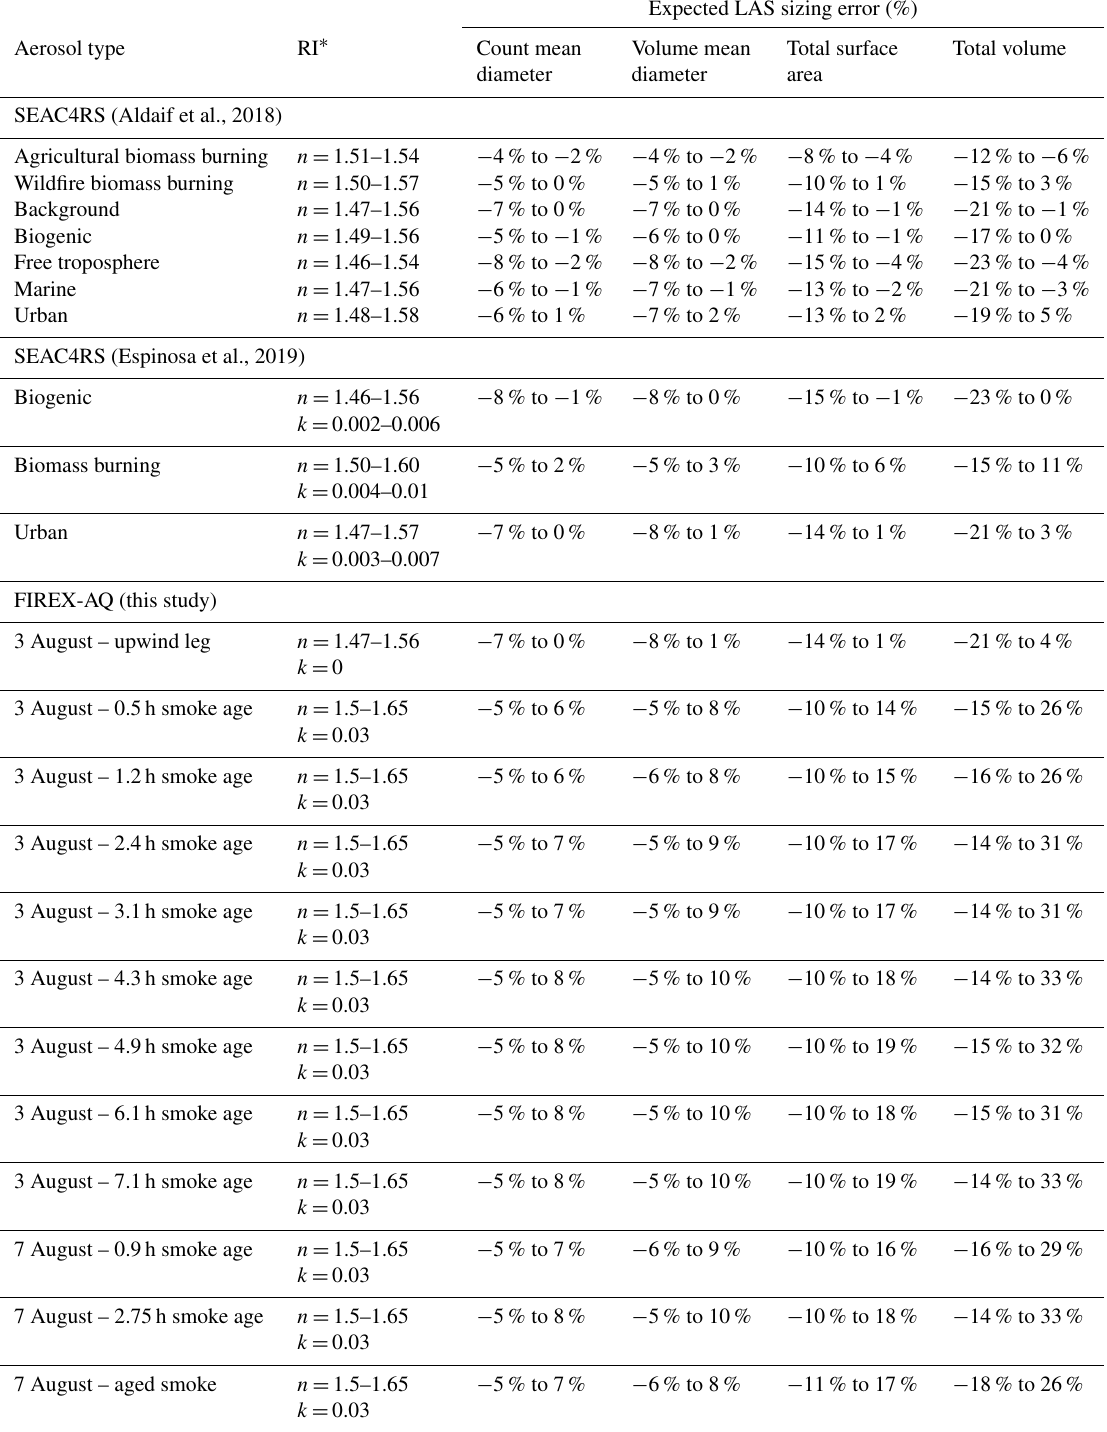
∗ RI range for SEAC4RS computed from literature values as the reported median ± 1 . 5 times the interquartile range for Aldaif et al. (2018) and as the mean ± 2 times the standard deviation for Espinosa et al. (2019). For FIREX-AQ, the RI is assumed to be dominated by the organic aerosol component, with a conservatively large range estimate for n , while k is computed following Saleh et al.